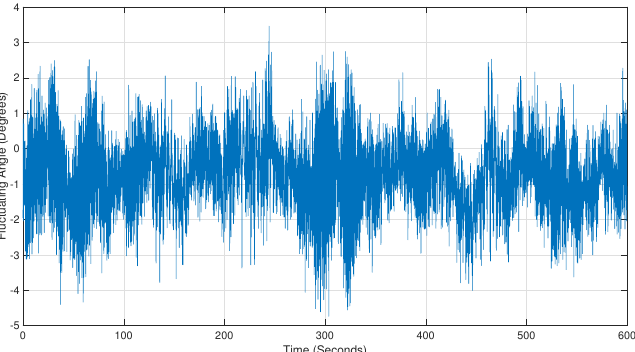
Figure 7. Aeroelastic model results for fluctuating angle between hub thrust and lateral forces for wind speed for a rated wind speed of 10 m/s.